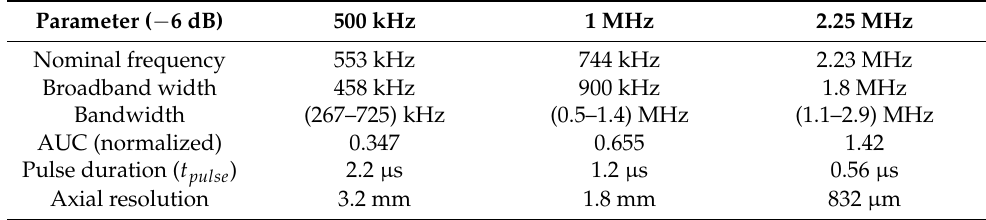
Table 4. Time and frequency ( − 6 dB) parameters of the transmitted signal, generated using the waveform generator and recorded using a 0.5 mm needle hydrophone; f 0 = 500 kHz, 1 MHz, 2.25 MHz ( c 0 = 1486